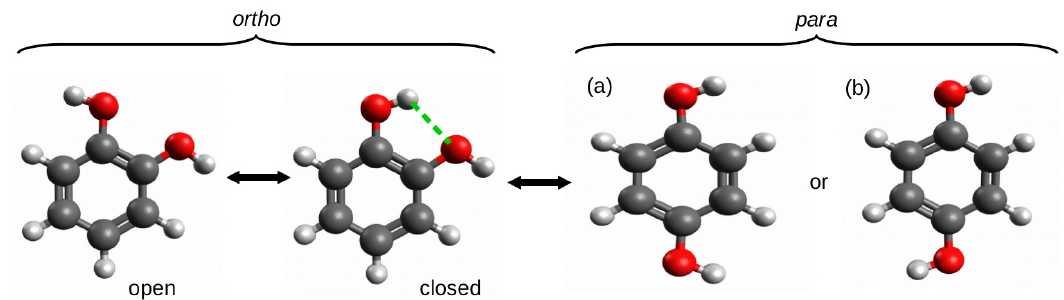
Figure 8. Various forms of catechol (the subfigures ( a ) and ( b ) represent different forms of para